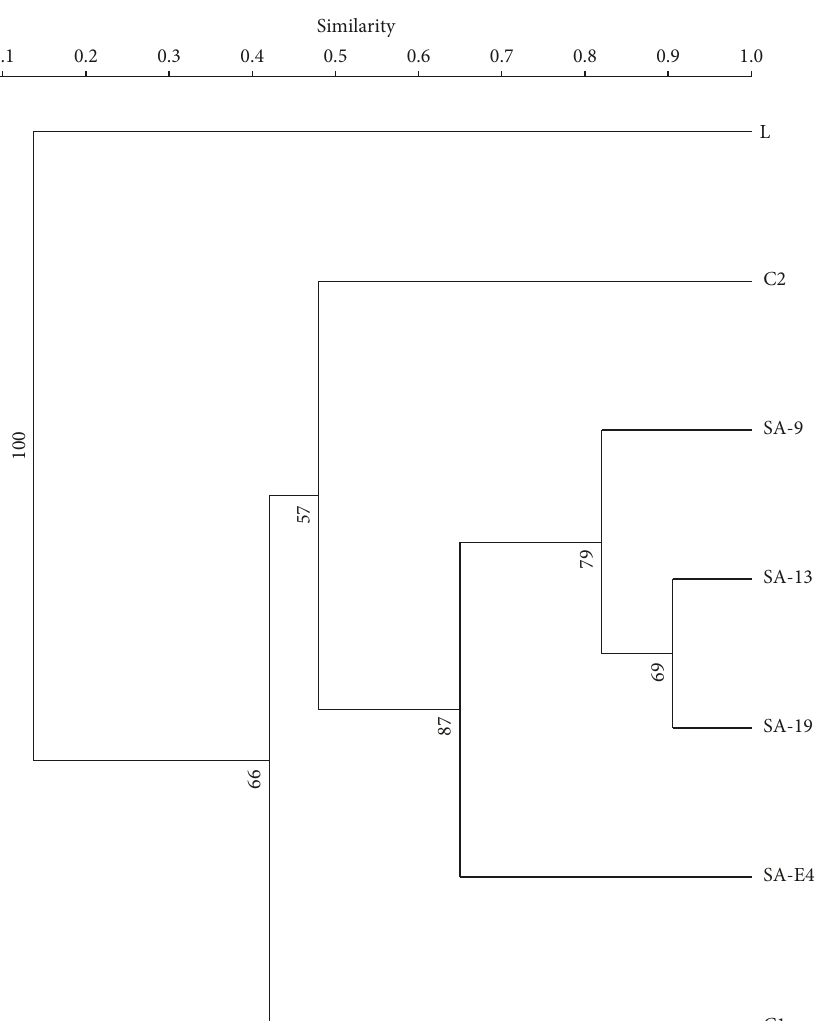
Figure 2: Dendrogram of isolated strains based on Jaccard’s similarity coefficient. Strains: SA-4E, SA-9, SA-13, and SA-14 ( Staphylococcus aureus isolated from food contact surfaces); C1 ( Staphylococcus aureus ATCC 25923); C2 ( Staphylococcus aureus ATCC 51811); L ( Lactobacillus delbrueckii subsp. bulgaricus ATCC